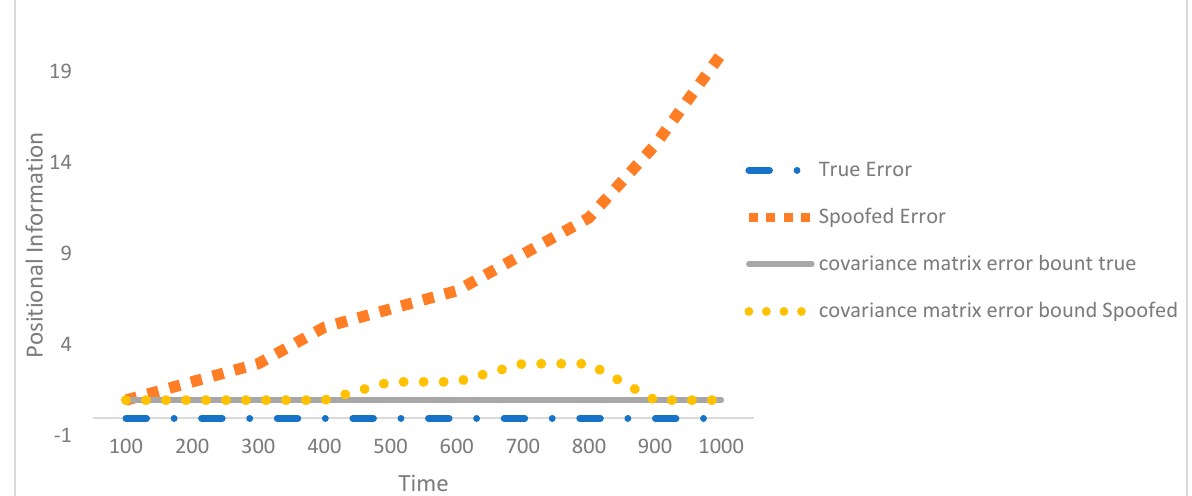
Figure 12. Error covariance matrix to check the effect of Monte Carlo simulation spoofing attack of different densities for low-intensity attack.